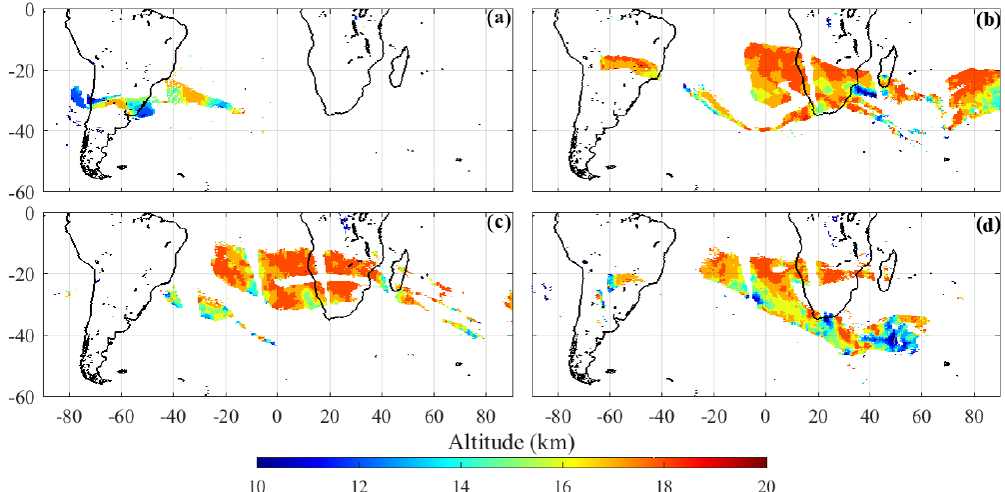
Figure 2. Injection altitude (km) and transport of SO 2 obtained from IASI observations on (a) 24 April, (b) 1 May, (c) 6 May, and (d) 11 May.